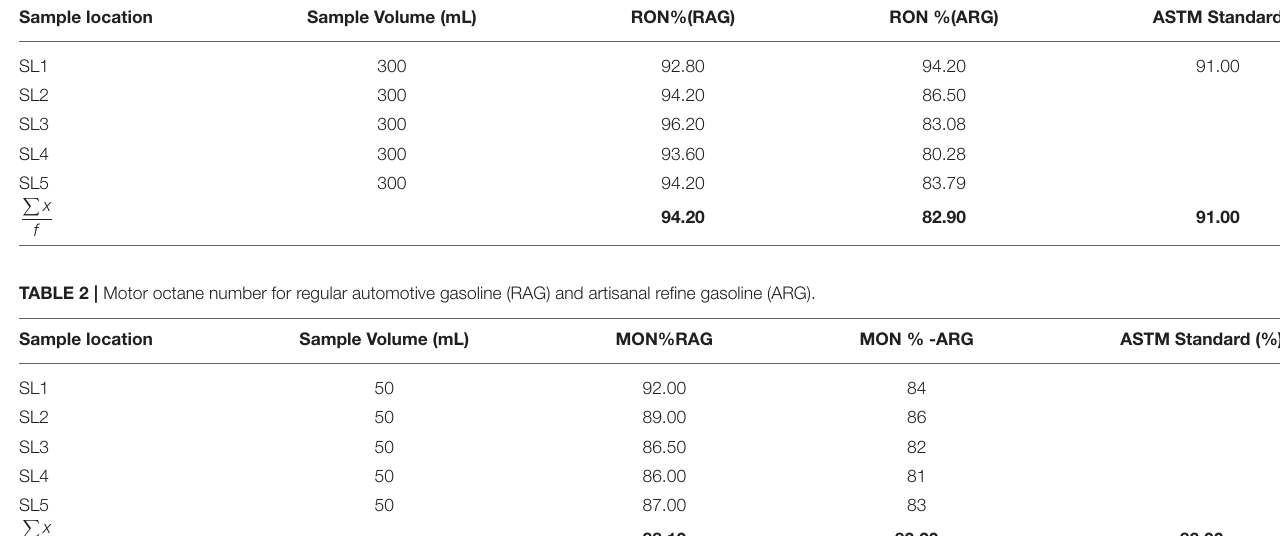
TABLE 1 | Research octane number for regular automotive gasoline (RAG) and artisanal refine gasoline (ARG). Sample location